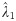
Estimation bias in error growth rate and direction using the EAKF for synthetic outbreaks.We use the EAKF to infer model parameters and variables for 1,000 different synthetic outbreaks generated using the humidity-driven SIRS model, and calculate the error growth rate λ^1 and direction e^1. Normalization denominators η(S) and η(I) are set as the 95 percentile of ensemble members’ deviations from ensemble mean. Distributions of the estimation bias in error growth rate Δλ=λ^1−λ1 and the angular deviation from e^1 to e1 (in degree from 0° to 90°) θ=arccos(e^1Te1) are reported in (A-B). The boxes and whiskers indicate the interquartile and the minimal and maximal values. The x-axis indicates the relative forecast time with respect to the predicted peak, i.e., forecast week minus predicted peak week. A negative predicted lead indicates the peak is predicted to occur in the future, whereas a positive lead indicates the peak is predicted to have already passed. For all predicted leads to peak, the deviation of the error growth rate, λ1, is distributed around 0, and the angular deviation of e1 is mostly below 10°. As a result, the error growth rate and direction estimated using the EAKF can be used to generate perturbations of the forecast system.